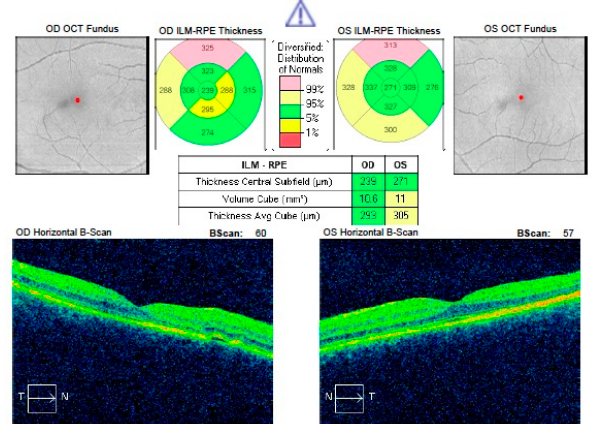
Figure 2. Comparison of CRT in resolved acute CSCR of the right eye with healthy left eye. CRT in the right eye is significantly reduced.